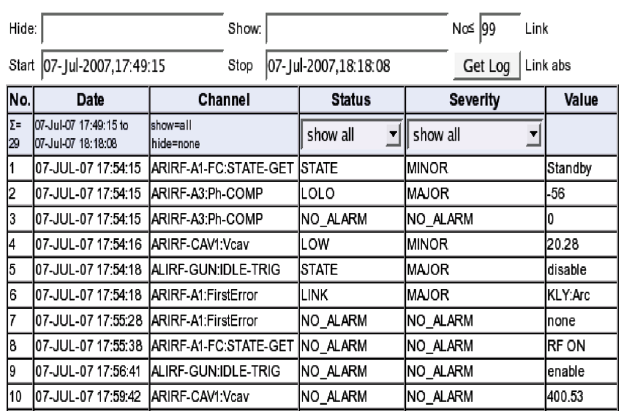
FIG. 6. (Color) Example screen shot of the Web interface of the alarmhandler .